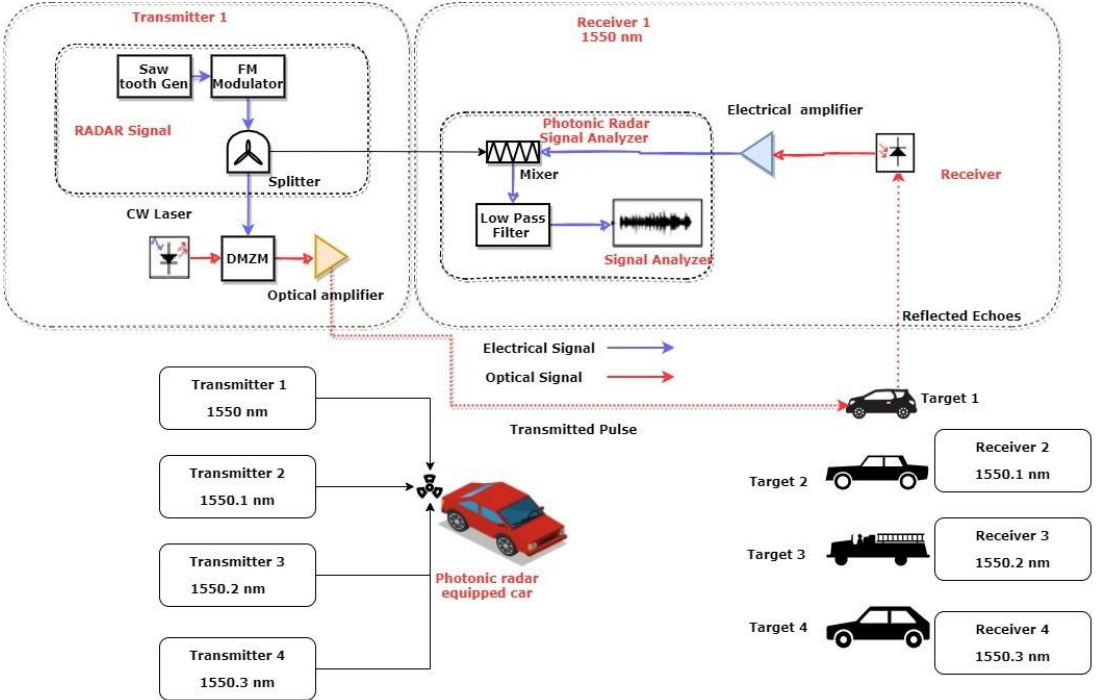
Figure 2. Schematic of proposed WDM-enabled LFMCW photonic radar. LFM: linear frequency modulator, DP-MZM: dual port Mach – Zehnder modulator, Tx/Rx: trans-receiver, EA: electrical amplifier, LPF: low-pass filter, WDM: wave-length division multiplexing.